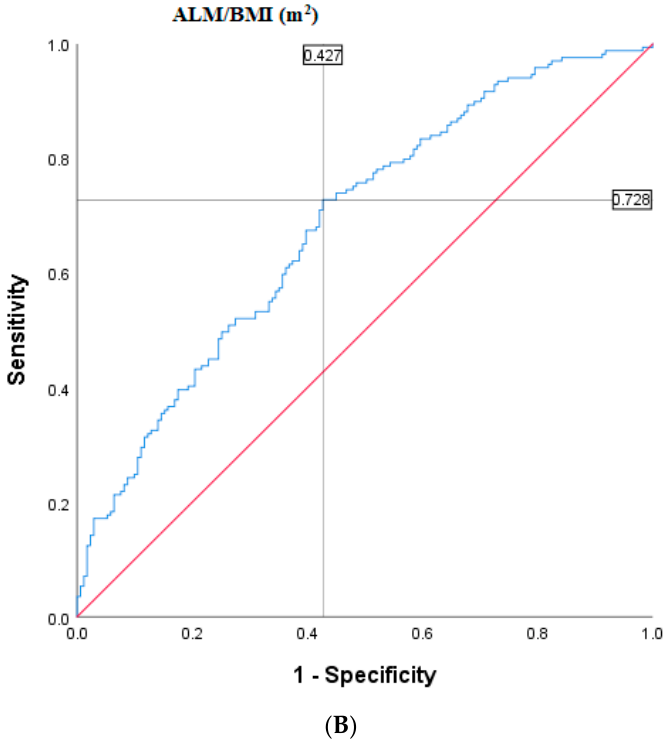
Figure A1. ROC analysis for optimal discrimination of slow timed up-and-go (TUG; slow TUG < 9.3 s) for ALM/BMI (( A , B ) for women and men, respectively). ( A ) ALM/BMI that best predicted slow TUG (Women); ( B ) ALM/BMI that best predicted slow TUG (Men).